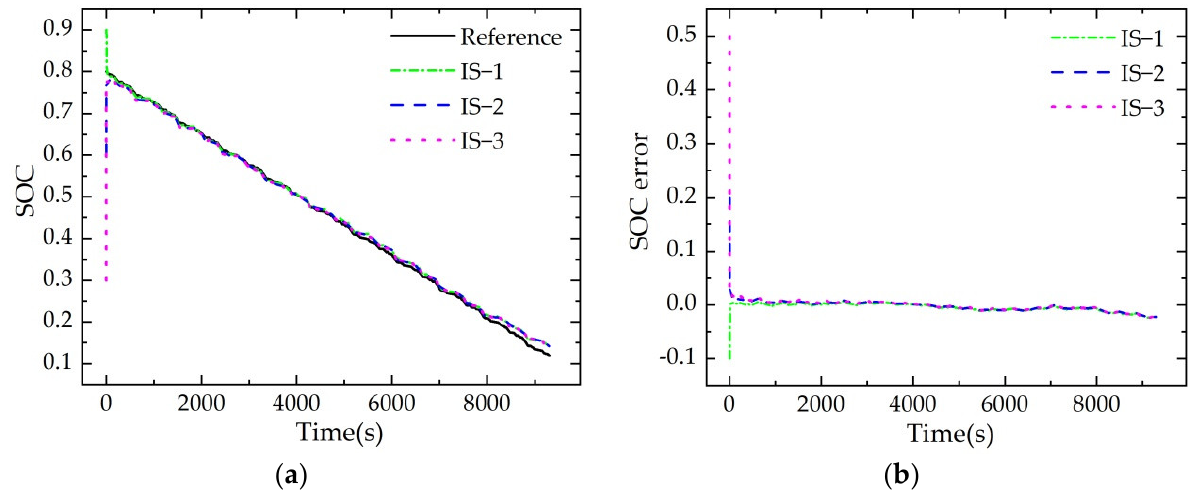
Figure 15. SOC estimation results in three cases under BJDST: ( a ) the estimated SOC; ( b ) the SOC error.